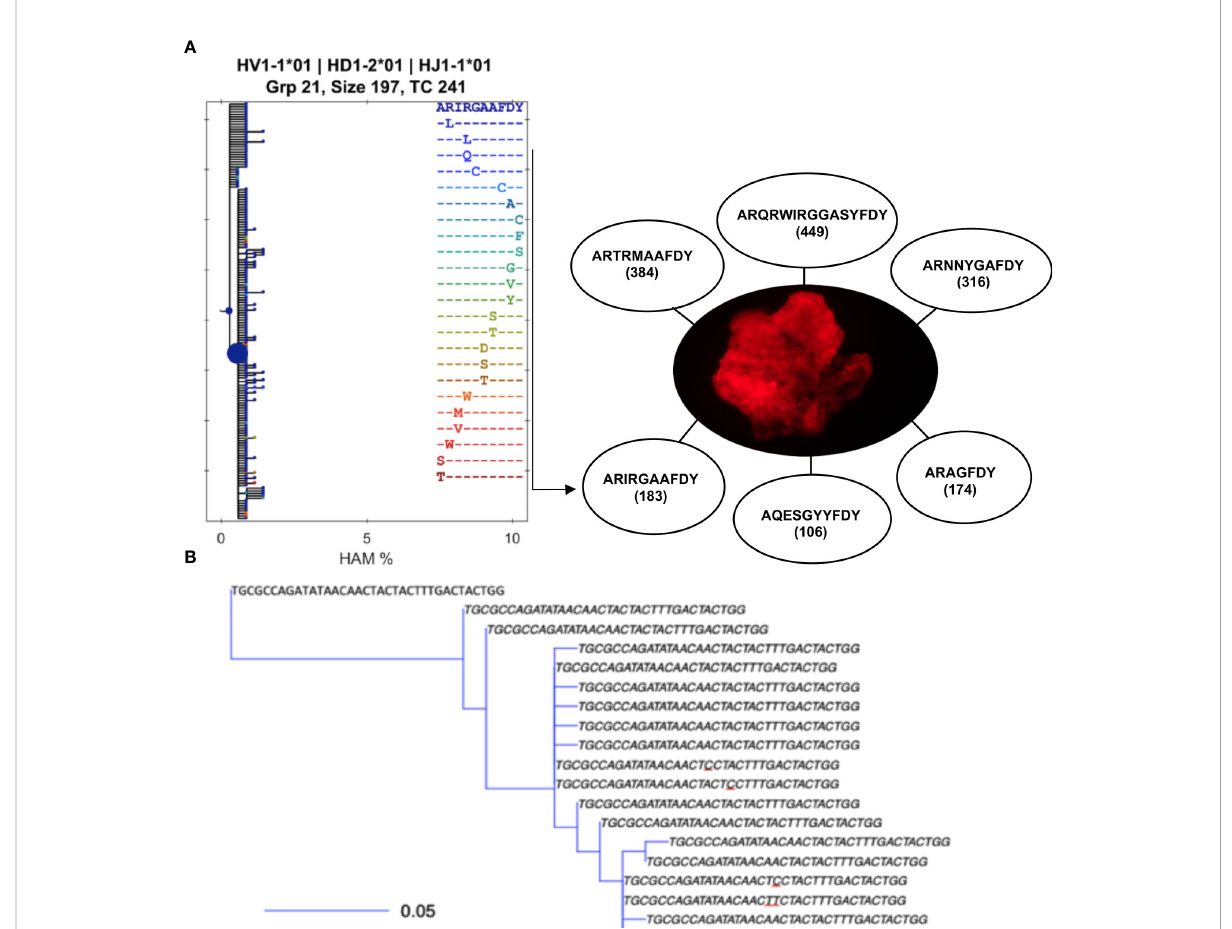
FIGURE 1 B-cell clonotypes proliferate within MM F Cs while acquiring mutations in the variable region of Ig genes. (A) Translated sequences of the CDR3 of the dominant clones within a single MM F C (F4UKCa) and the number of putative daughter cells. Lineage tree using BRILIA shows only the different CDR3 sequences (there are 183 unique sequences in this clone but only 24 unique CDR3 sequences). Each dot of the left hand tree represents a unique sequence, and each dot color corresponds to a unique CDR3 sequence. The dot size re fl ects the total copy number of each sequence. The x-axis shows the percent of Hamming distance calculated based on the number of nucleotides at which two sequences of the same length differ. (B) An example of part of a smaller lineage tree using BuildTrees, IgPhyML (HLP19 model) and Alakazam (igraph), CDR3 nucleotide sequences of all the unique sequences (the size of this sub-clone is 35 sequences). A few of the CDR3 sequences are unique to specifc sequences with mutated nucleotides (underlined nucleotides). Some branches have their de fi ning mutation outside of the CDR. The scale bar represents the branch length (expected number of substitutions per codon site). The analysis was done using IgPhyML and BRILIA. HAM %, is the percent of Hamming distance which is calculated based on the number of nucleotides at which two sequences of the same length